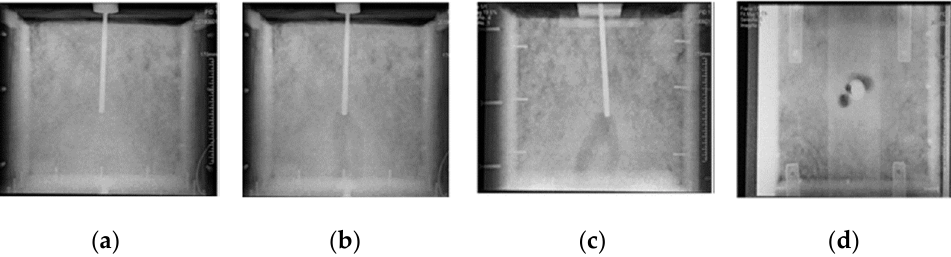
Figure 11. Images of modified soil with the SAP content of 0.5%: ( a ) Before breakdown; ( b ) front view; ( c ) side view; ( d ) top view.